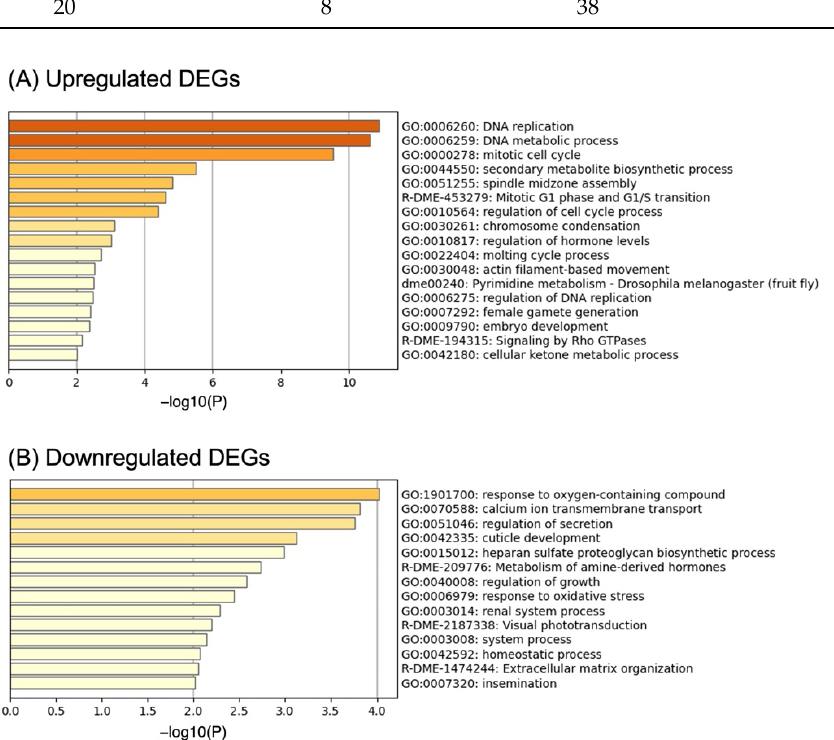
Figure 2. Results of gene set enrichment analysis in ( A ) upregulated DEGs and ( B ) downregulated DEGs.